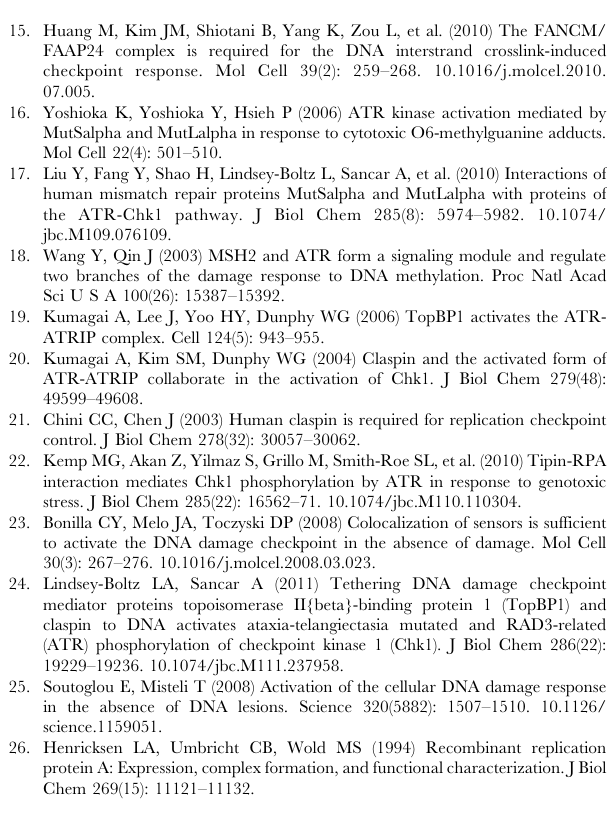
Figure S1 Analysis of Timeless, Tipin, and Claspin fragment binding to DNA substrates. The indicated fragments of (A) Timeless, (B) Tipin, and (C) Claspin were purified from either insect or bacterial expression systems and analyzed for binding to the indicated DNA substrates as described in the Methods section. For each protein, a diagram of the purified protein fragments is provided (top), along with a coomassie-stained gel showing the purified fragments (middle), and immunoblot analyses of protein binding to the DNA substrates (bottom). Input represents 5% of the protein used in the binding